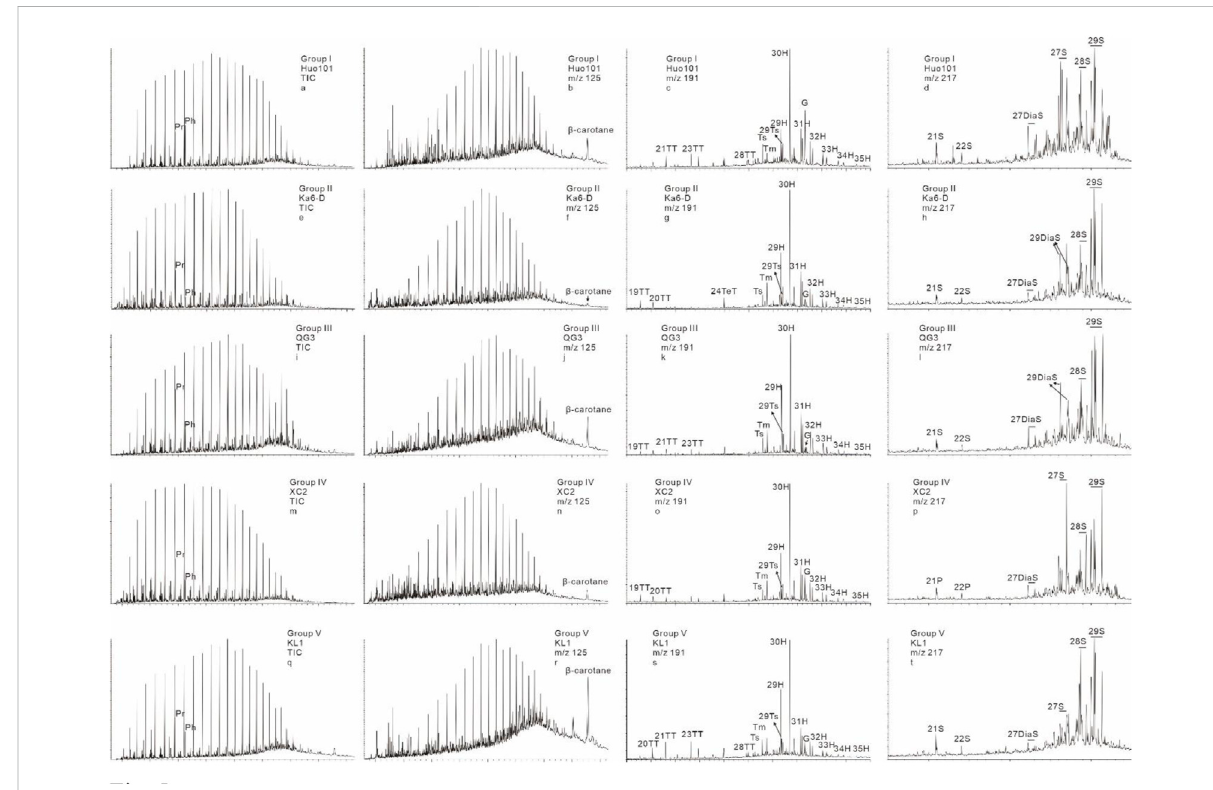
FIGURE 5 Summarized TIC, m/z 125, m/z 191, and m/z 217 mass chromatograms of saturated hydrocarbons showing distributions of n- alkanes and acyclicisoprenoids, β -carotane,terpanes,andsteranesfor (A – D) GroupIoil; (E – H) GroupIIoil; (I – L) GroupIIIoil; (M – P) GroupIVoil; (Q – T) GroupV oil. The abbreviations of compound names see Figure